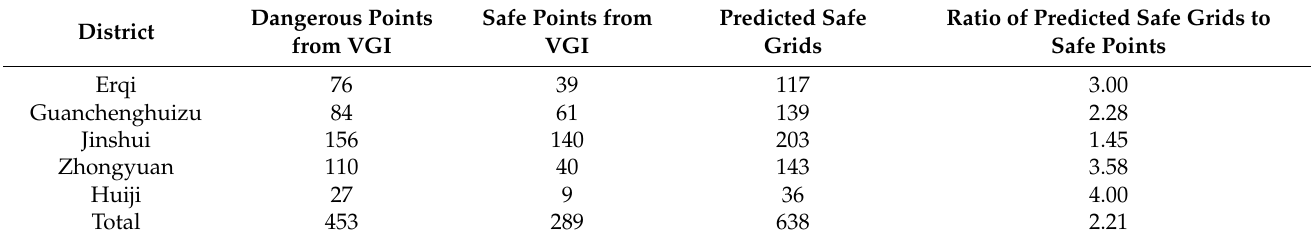
Table 5. Comparison of predicted results and actual